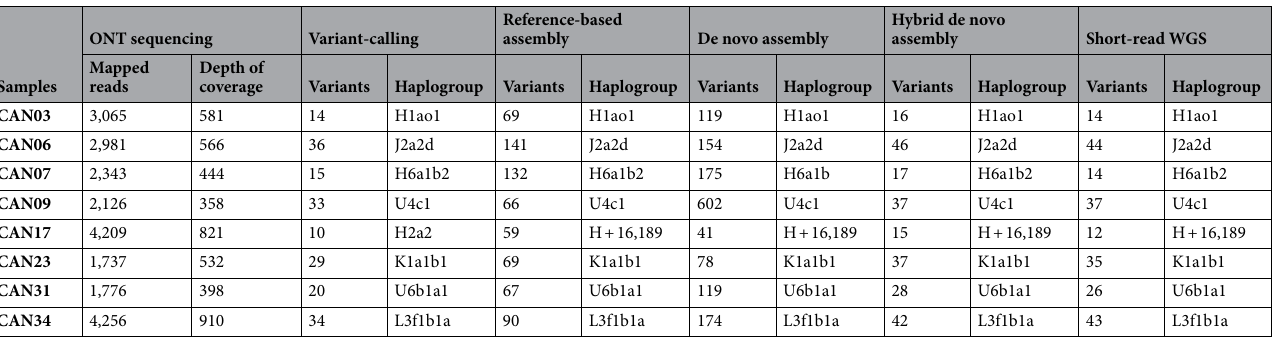
Table 3. Long-read (ONT) sequencing summary and haplogroup classification results for the samples. The results of the short-read whole-genome sequencing (WGS) mtDNA classification are also